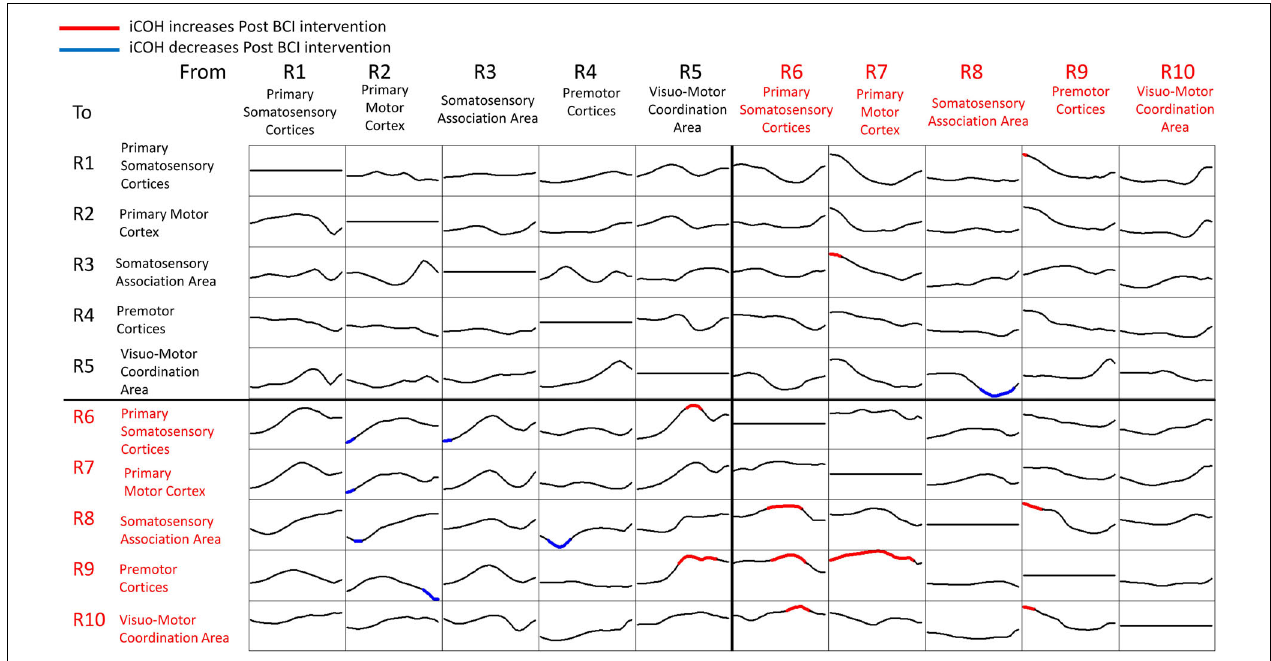
FIGURE 7 | Plots of t-statistics for isolated effective coherence (iCoh) values Post vs. Pre BCI intervention of left (i.e., impaired hand) movement trials. Vertical axis: 0 to 1. Horizontal axis: spectral frequency: 4–30 Hz. Columns are the senders, rows are receivers (i.e., FROM the top row of ROIs TO the horizontal columns of ROIs). Red portions of the iCoh between two ROIs denote coherence increases at relative frequencies from Pre to Post, whereas blue portions denote significant decreases in iCoh from Pre to Post between two ROIs. Mean values (Pre, Post) compared via paired-sample t -statistics, with threshold set at t = 2.13 [df = 15], p = 0.05, uncorrected for multiple